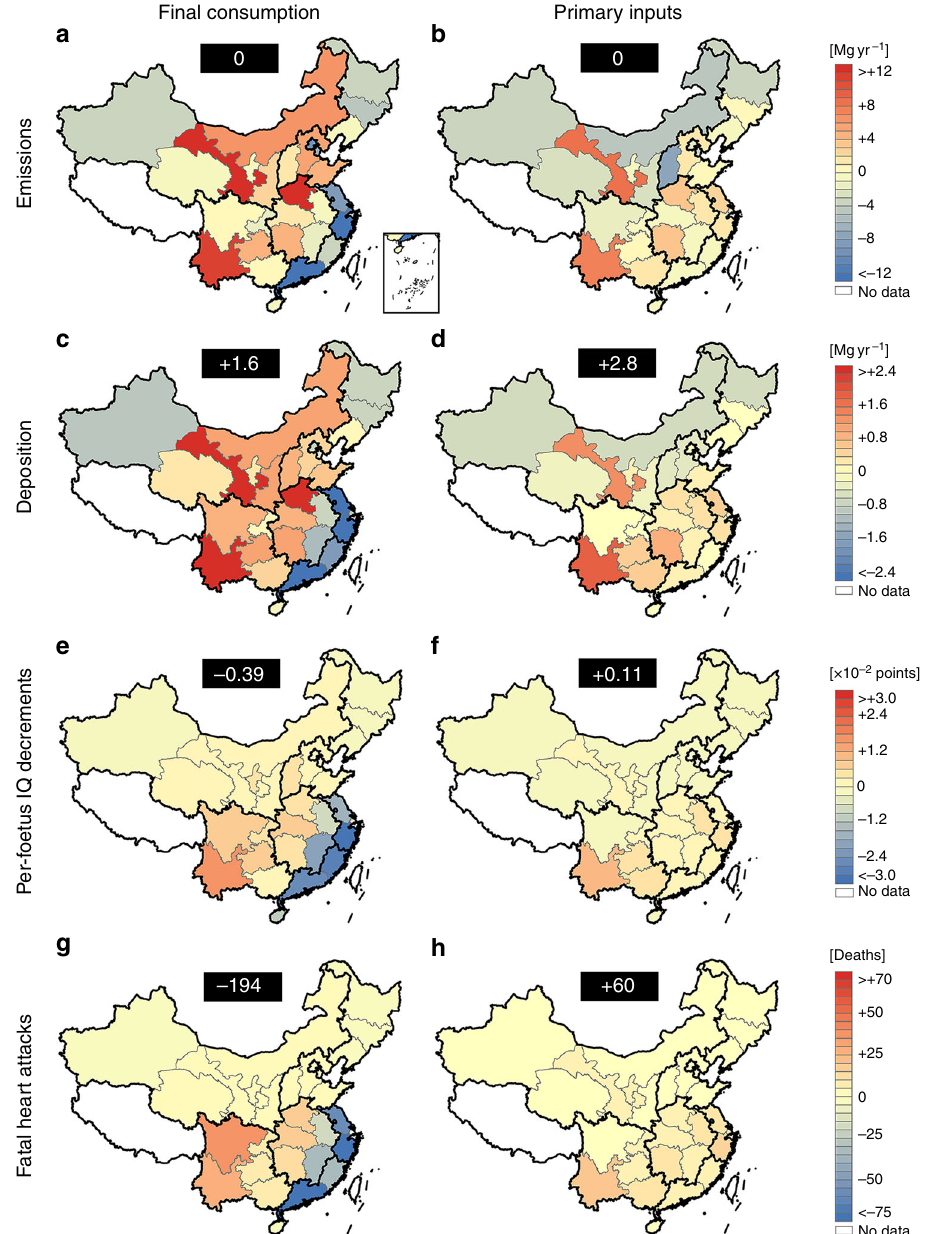
Fig. 4 Spatial relocation of atmospheric mercury (Hg) emissions and deposition as well as Hg-related intelligence quotient (IQ) decrements and fatal heart attacks over China due to interprovincial trade. The relocation is evaluated by the difference between interprovincial trade of products versus producing the same products locally under a hypothetical absence of interprovincial trade. a , c , e , g The results for the interprovincial trade of products induced by fi nal consumption, and b , d , f , h the results for the interprovincial trade of products enabled by primary inputs. The number at the top of each panel shows the net national change with the sum of changes in all